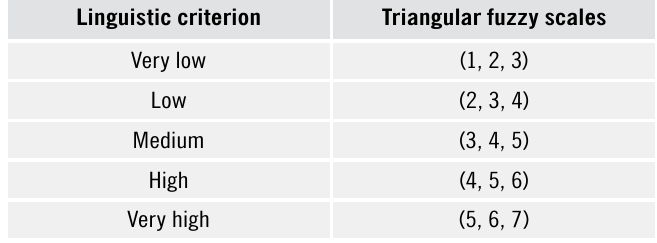
Table 1. Linguistic criteria for pairwise comparisons and their fuzzy